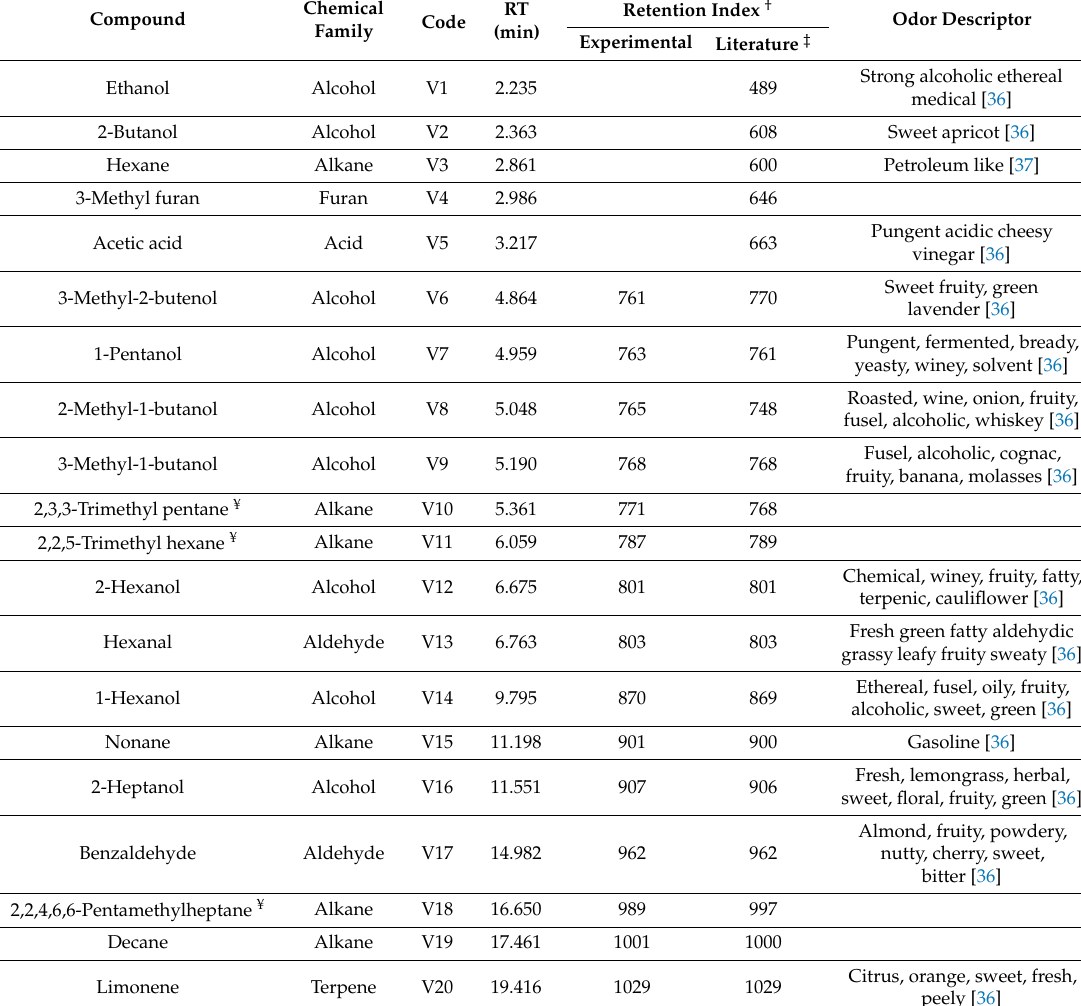
Table 3. Profile of volatile compounds in almonds, retention index, and main odor and aroma